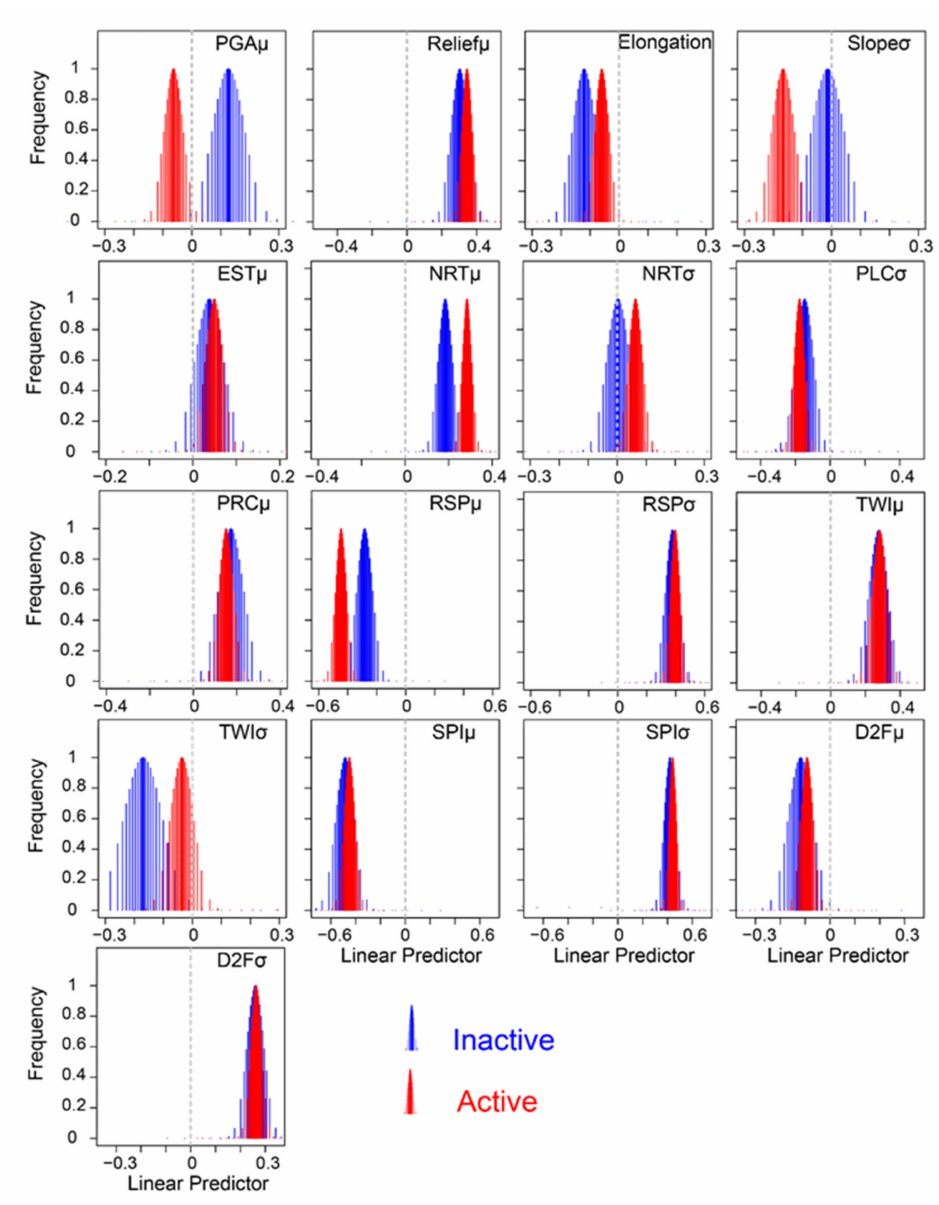
Figure 3. Fixed effects of geomorphological variables expressed as marginal distributions for inactive and active